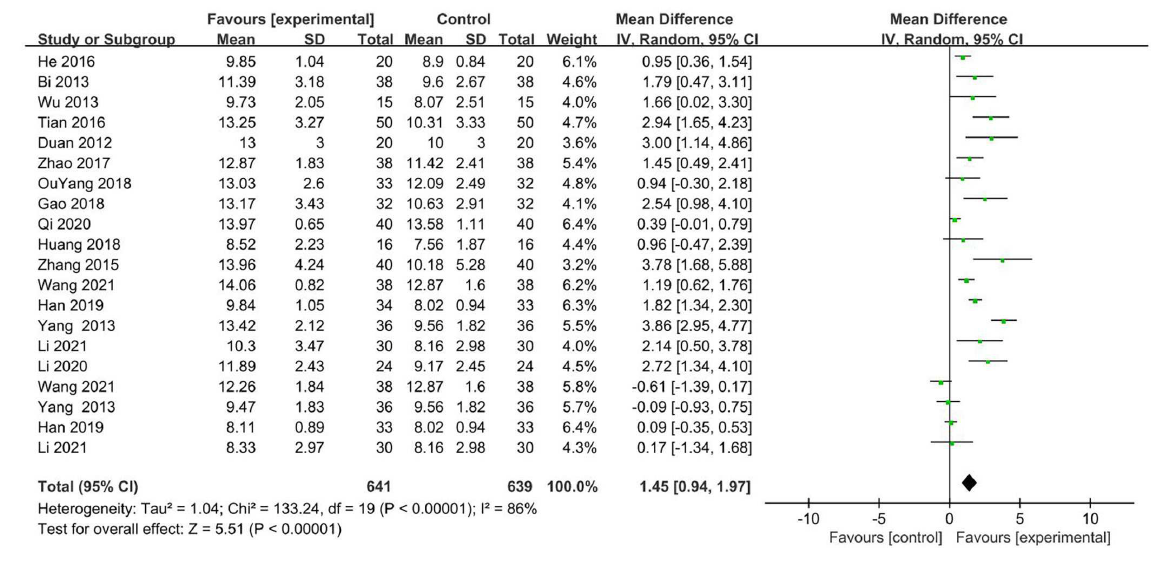
FIGURE3 Forest plot and meta-analysis of GCS (Glasgow coma scale).